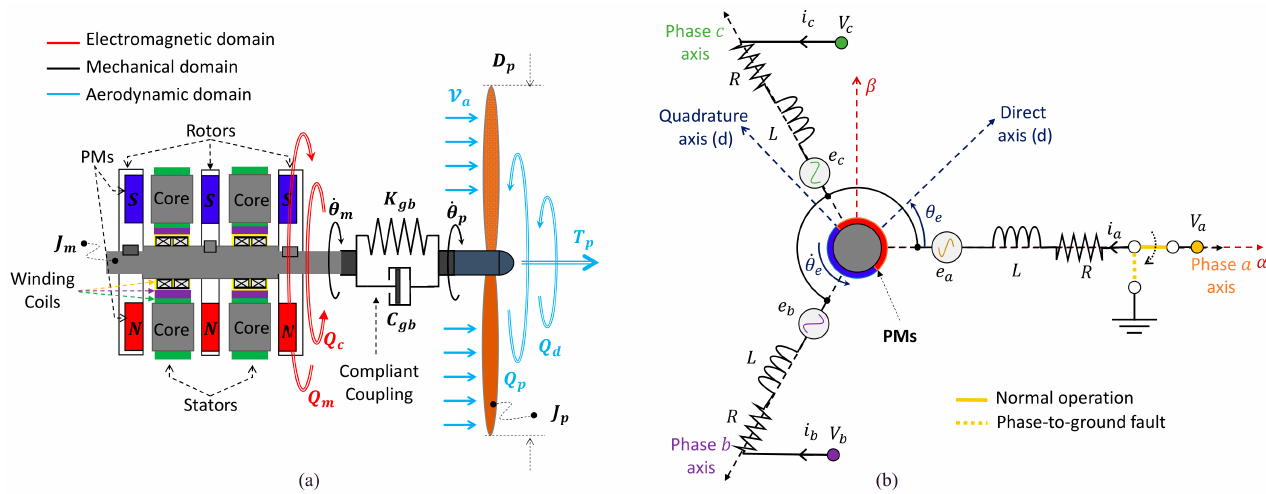
Figure 4. FEPS: ( a ) mechanical scheme; ( b ) equivalent three-phase PMSM scheme (one pole